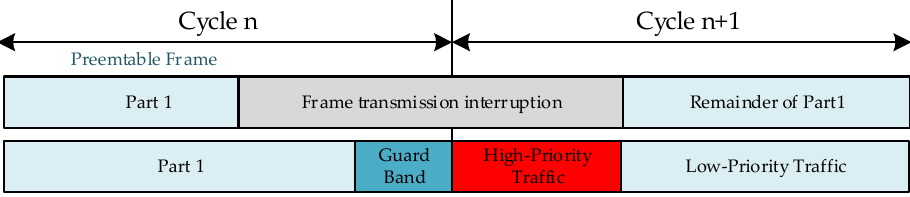
Figure 1. Frame preemption mechanism [17].